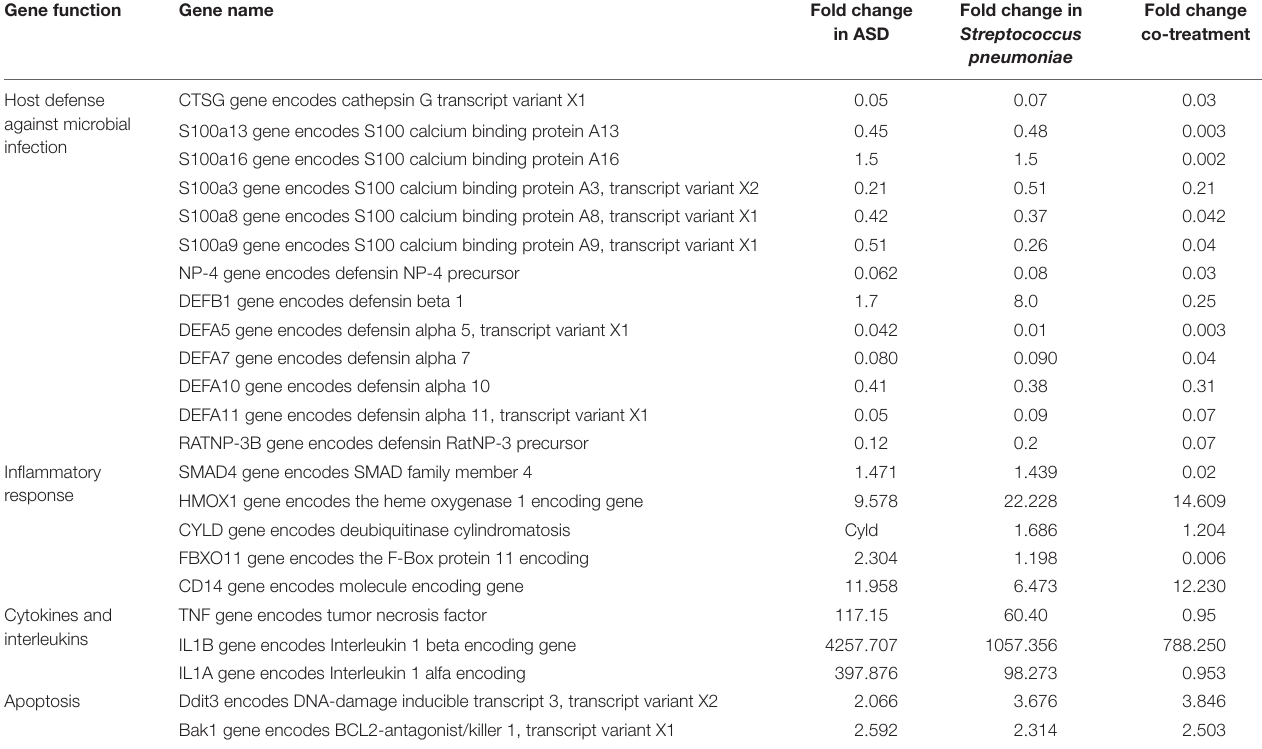
TABLE 2 | Otitis media-related differentially expressed genes in rat mucosa treated with ASD or Streptococcus pneumoniae or co-treatment. Gene function Gene name Fold change